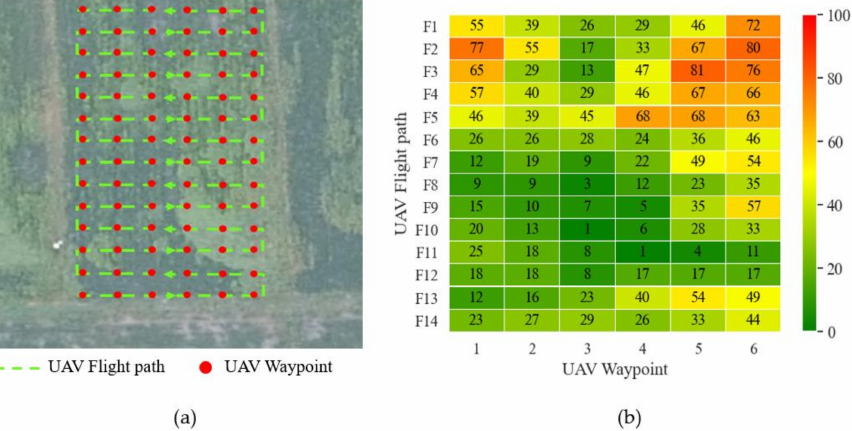
Figure 13. UAV actual operation route planning and distribution map of weed density prediction. ( a ) UAV actual operation route planning; ( b ) Distribution map of weed density